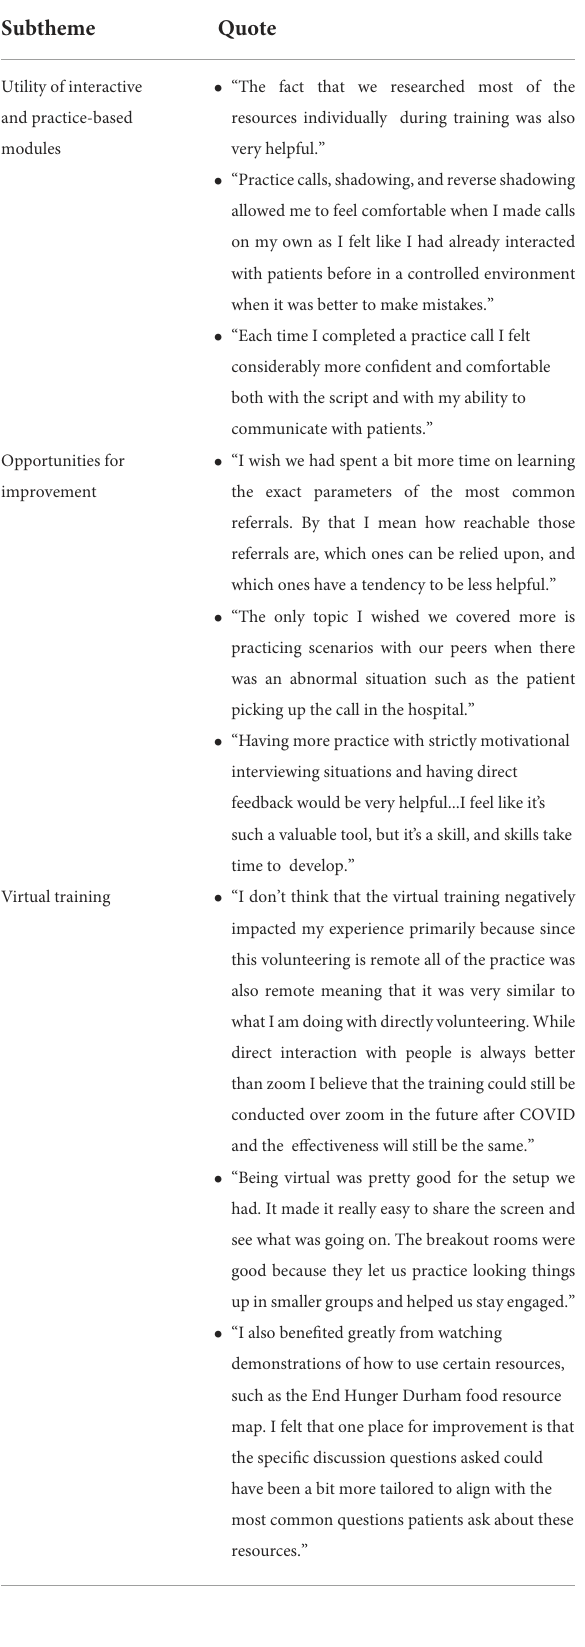
TABLE 2 Representative quotes of learner feedback on student experience and delivery of training